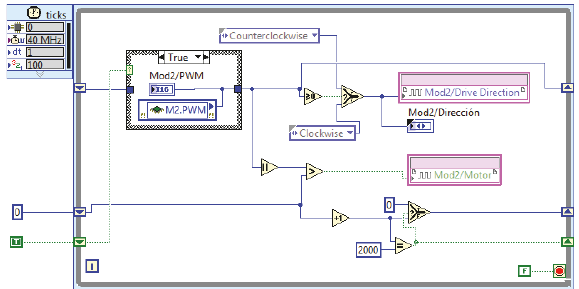
Figure 11: PWM signal control